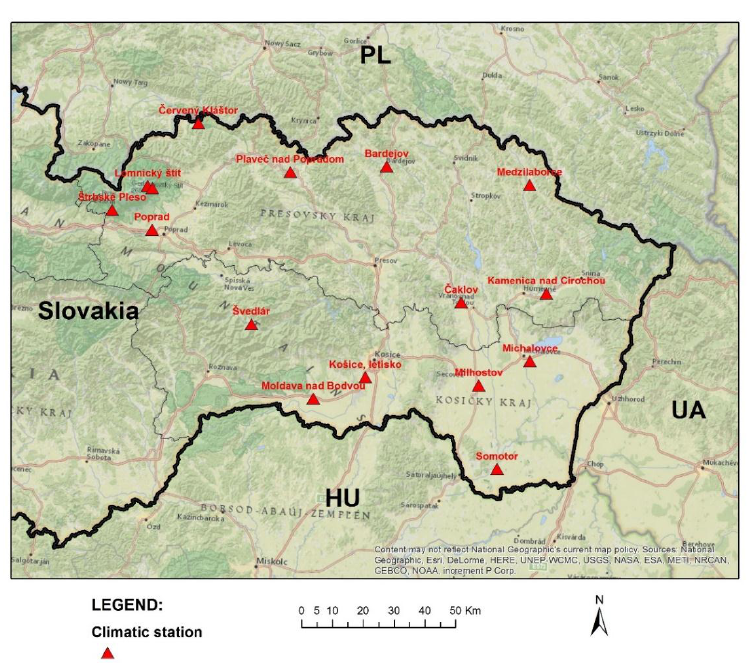
Figure 1. Study area.